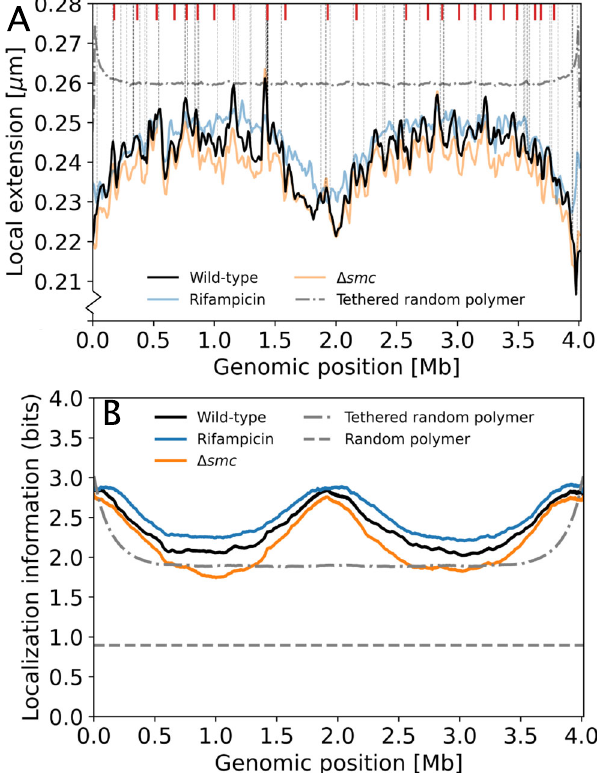
Fig. 5 The MaxEnt model reveals local features and localization information encoded by chromosome organization. A The local chromosome extension δ i as a function of genomic position. δ i is de fi ned as the spatial distance between neighboring genomic regions of site i averaged over all chromosome conformations. Model predictions are shown for wild- type cells (black), rifampicin-treated cells (blue), Δ smc cells (orange), and a pole-tethered random polymer (gray dash-dotted line). The locations of the top 2% highly transcribed genes are indicated by vertical gray dashed lines, the locations of CIDs determined in ref. 26 are indicated by red markers. B Localization information per genomic region in bits for wild-type (black), Δ smc (orange), rifampicin-treated cells (blue), a random pole-tethered polymer (dash-dotted line), and a random polymer (dashed